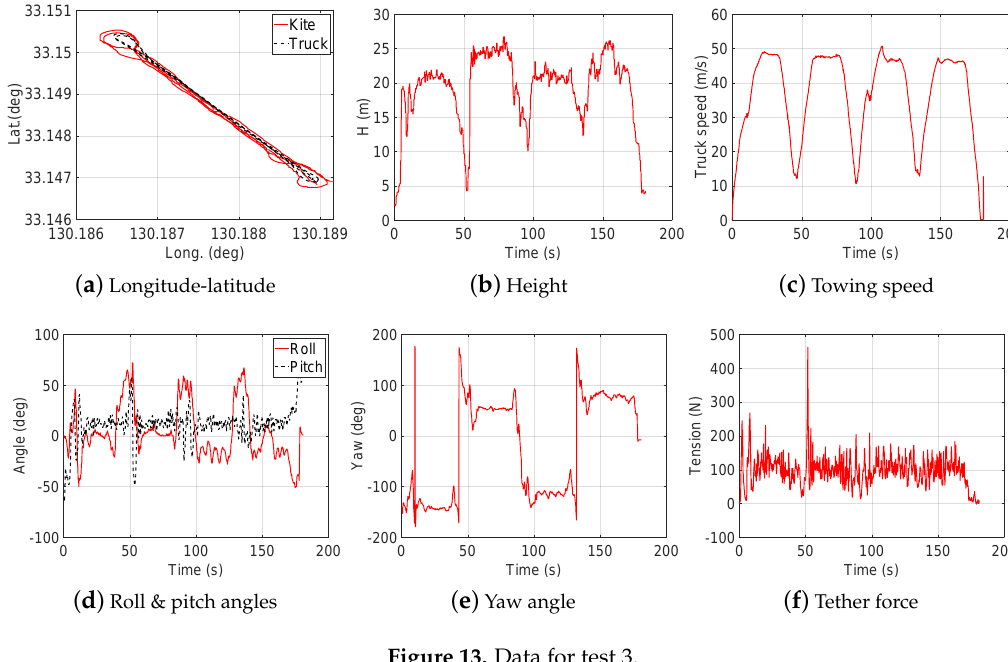
Figure 13. Data for test 3.